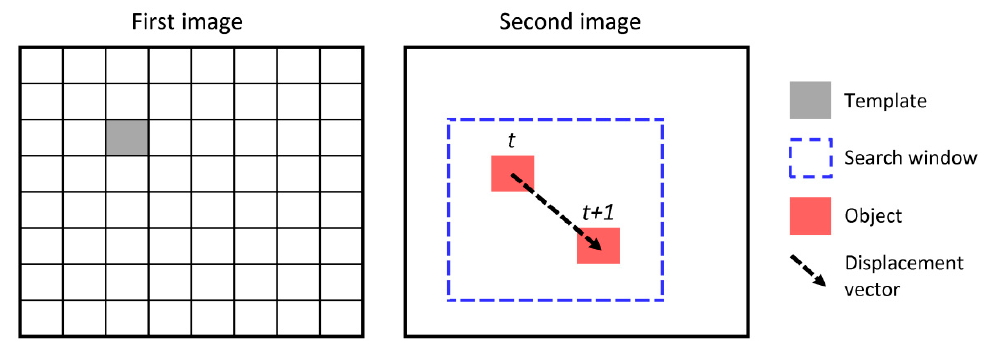
Figure 1. Depiction of the Maximum Cross-Correlation (MCC) method, including a template, search window, and displacement vector. Example feature (in red) within a given template extent at time t is shown, as is the direction and magnitude of shift in the feature position at time t + 1, relative to that at time t (after [6]).